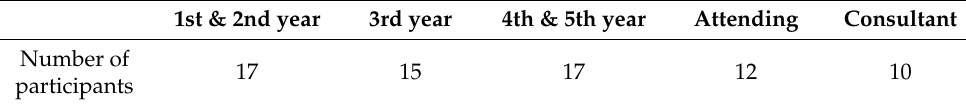
Table 1. Number and anaesthesiology training levels of the study